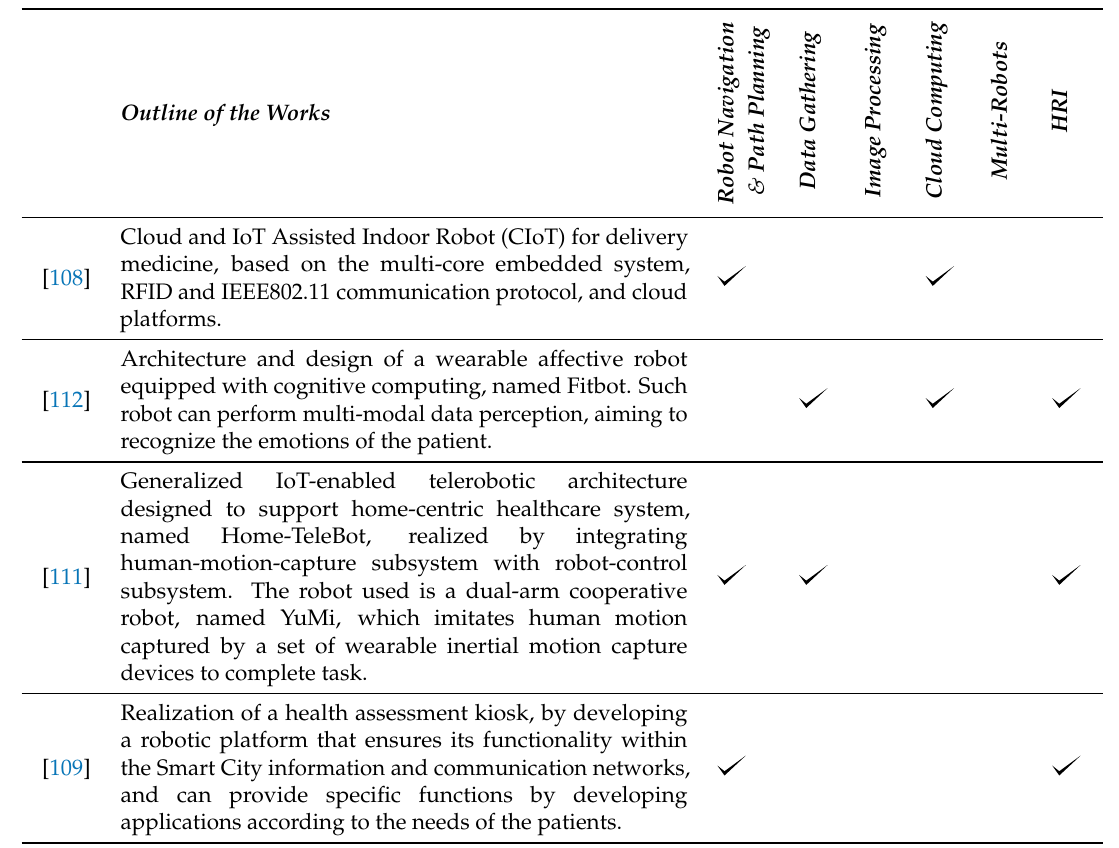
Table 3. Overview of the literature considered for the Health-Care, Education and Surveillance domains, from 2018